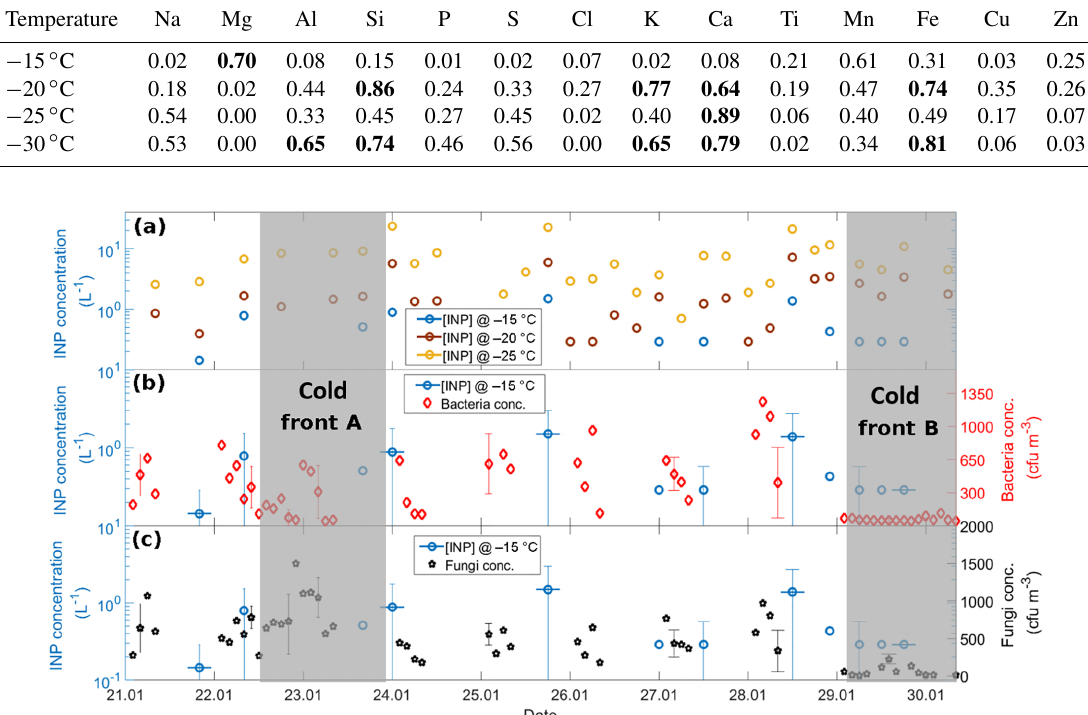
Table 2. Correlation coefficients ( r 2 ) of the average chemical composition and the average [INP] per sample at − 15, − 20, − 25, and − 30 ◦ C. Bold text highlights the r 2 with p < 0 . 05 (Table S1) for each temperature. The correlations were obtained for five sample points at each temperature.